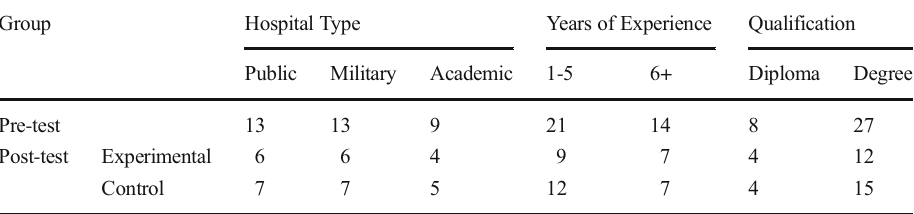
Table 2 Demographic profile of the participants